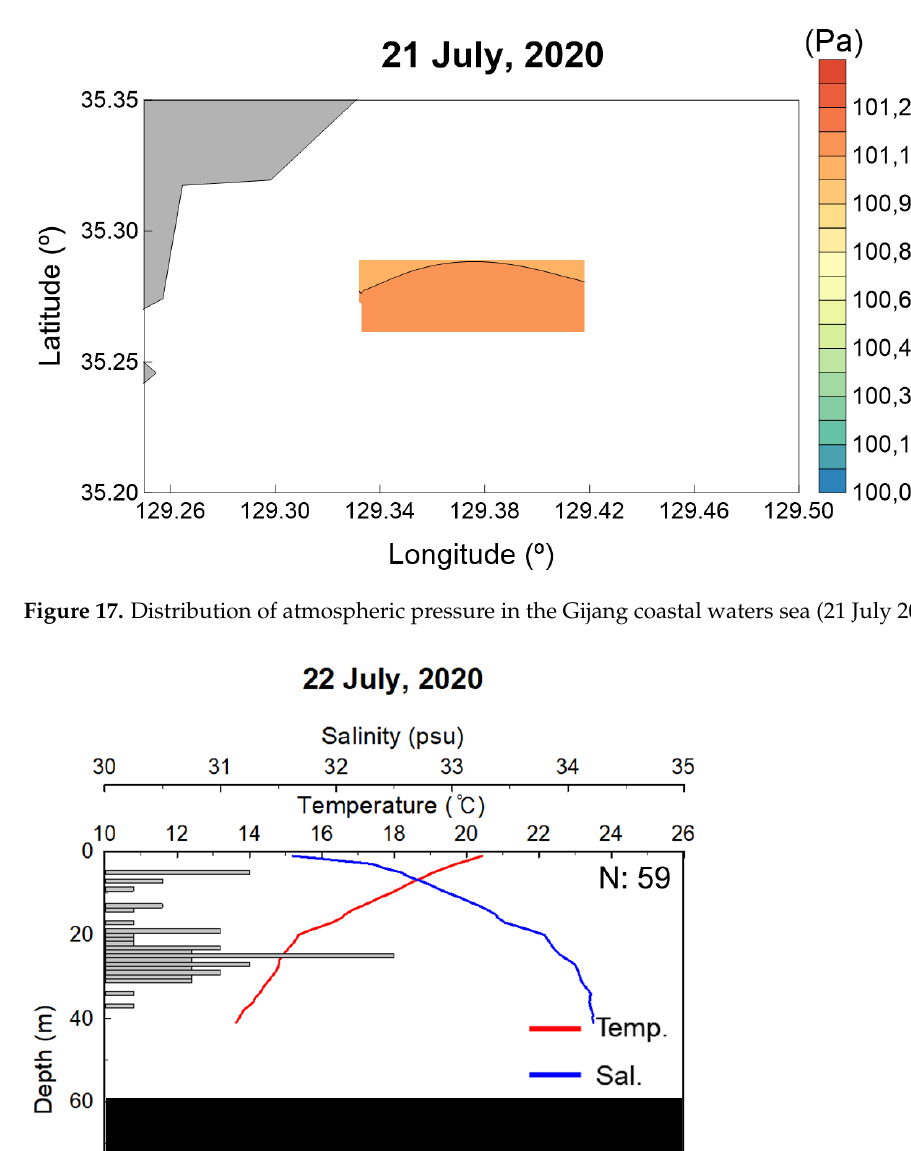
Table 13. Distribution density of jellyfish using the sighting method in the Gijang coastal waters sea (7/22). Site Ind.